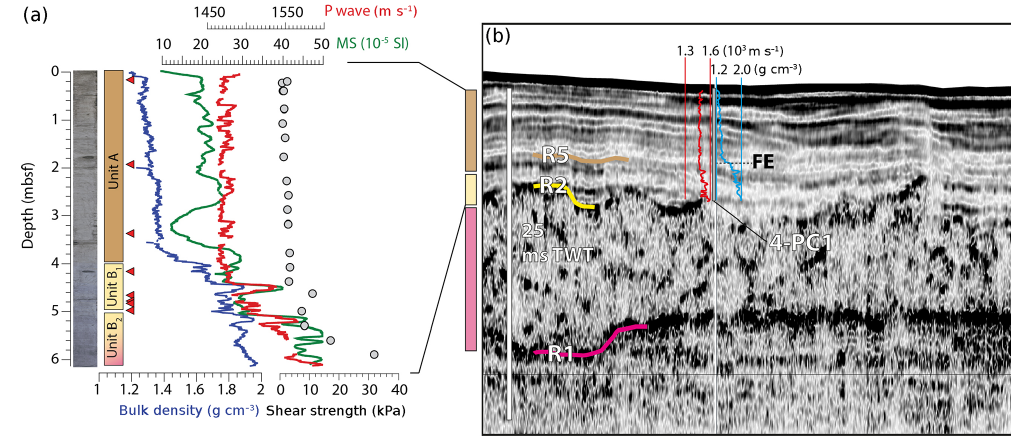
Figure 6. Core–seismic integration of 4-PC1. (a) Core image, interpreted lithologic units and sediment physical properties. Lithologic units are colored to match the interpreted seismic stratigraphy in Fig. 5. Uncertainty related to whether subunit B 2 penetrated reflector R2 is shown by faint pink shading. (b) Measured physical properties (p-wave velocity, bulk density) of core 4-PC1 overlaid on the chirp sonar profile crossing the coring site. The core depth is resampled to TWT using the measured p-wave velocity. FE marks the location in the core interpreted to represent the flooding event of the Bering Strait. Note that the location of the p-wave velocity and bulk density curves are slightly offset from the coring site (marked by a gray bar) for display purposes.